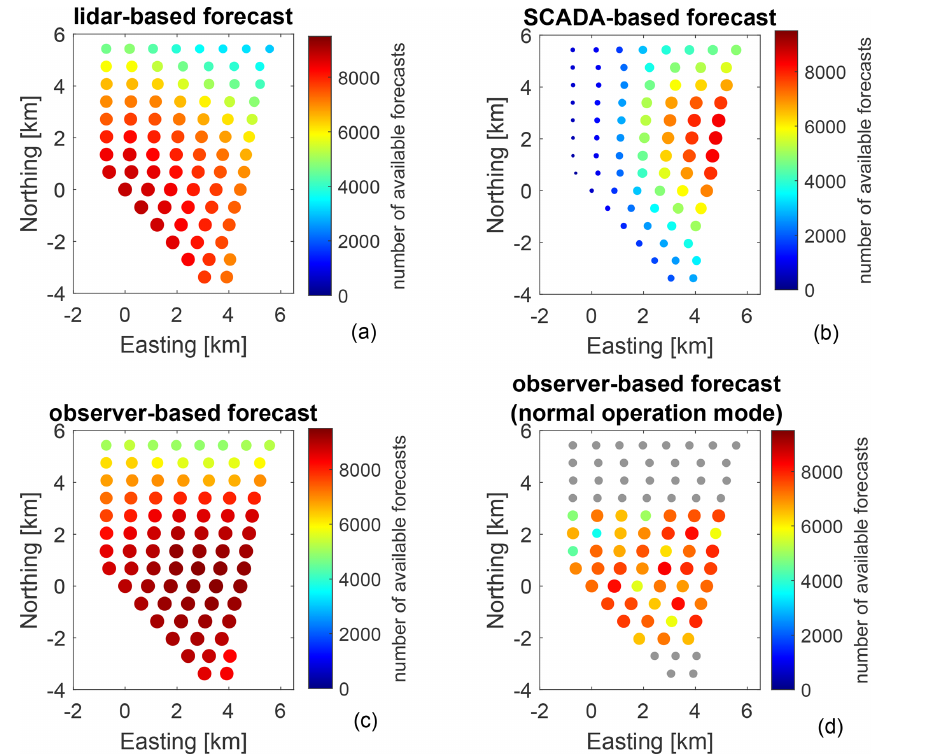
Figure 3. Forecast availability for (a) the lidar-based forecast, (b) the SCADA-based forecast, (c) the observer-based forecast and (d) the observer-based forecast after filtering situations during non-normal operation. The subset of turbines shown in colours in (d) is analysed in more detail in this work, while turbines marked in grey are not considered for further analysis. The colour scale and magnitude of the dots visualize the number of valid